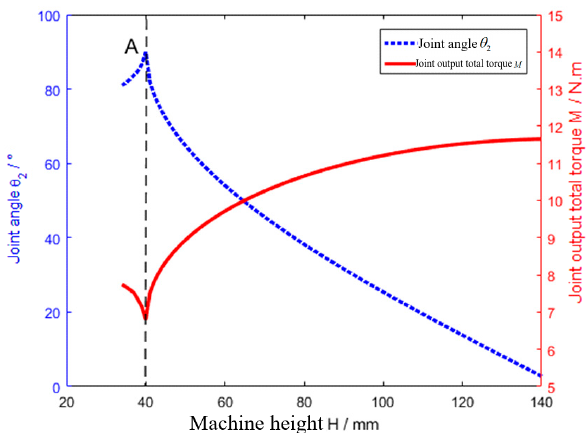
Figure 4. Minimum of M under different of center of gravity heights.